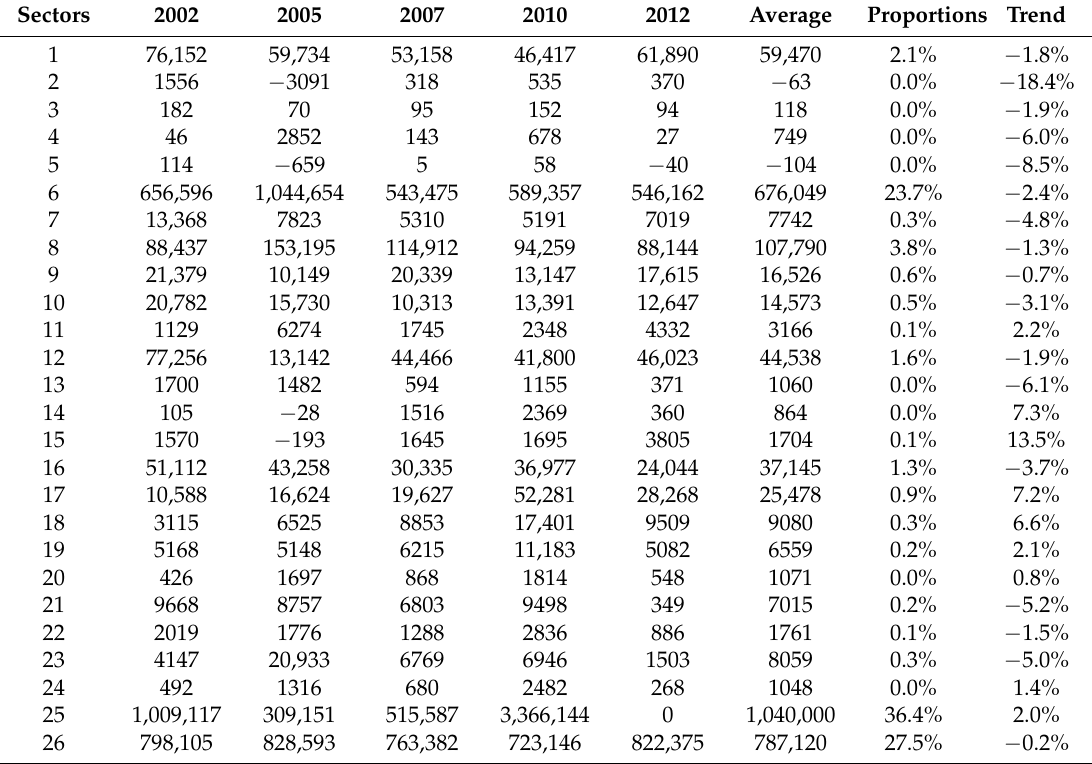
Table 4. Sectoral virtual grey water footprint of China from 2002 to 2012. (Unit: million m 3 ).